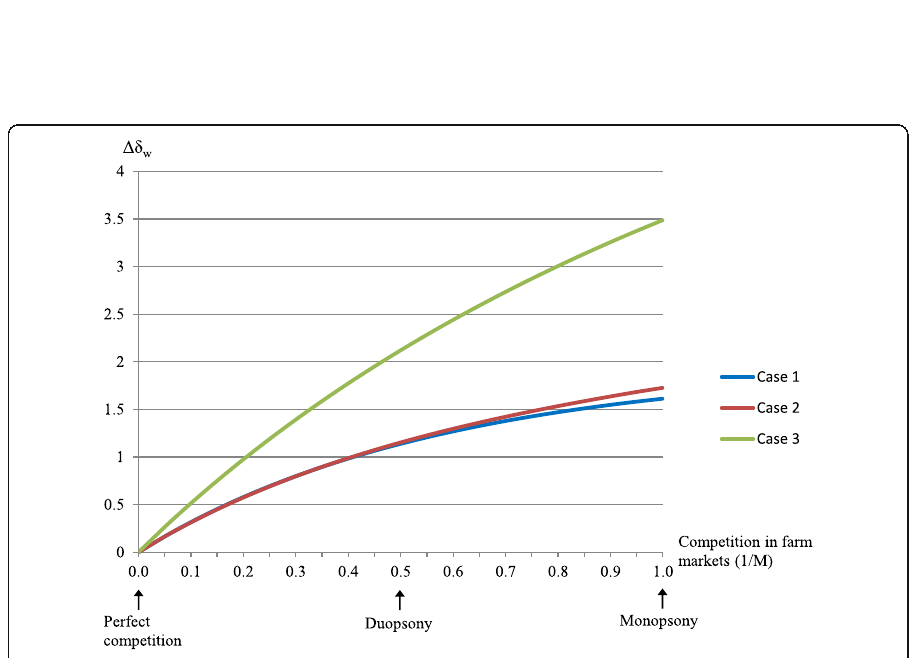
Fig. 4 The increase ( Δ δ w ) in processors ’ profit margin due to the weakened seller power in retail markets under various levels of buyer power in agricultural procurement. Note: Δ δ w is the increase in processors ’ profit margin when retailers ’ seller power is weakened from N = 2 to N = 3. The increase ( Δ δ w ) is larger when the processors have stronger buyer power in farm markets. Case 1 is when there is a competitive wholesale market. Case 2 is when there is an oligopoly wholesale market. Case 3 is when there is an oligopsony wholesale market. Processors ’ profit margin increase in case 3 (green line) is larger than that in case 1 (blue line). The relative magnitudes between processors ’ profit margin increase in case 2 and those in cases 1 and 3 depend on various market factors so that all (in)equalities between them are